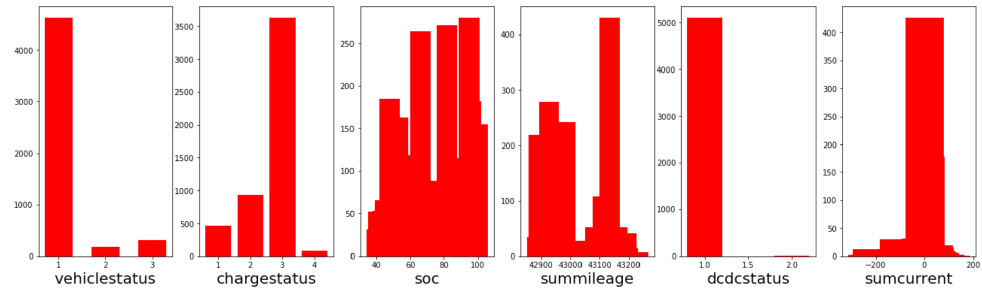
Figure 9. Battery data visualization. Table 6. Mean, variance, maximum value, and minimum value of battery